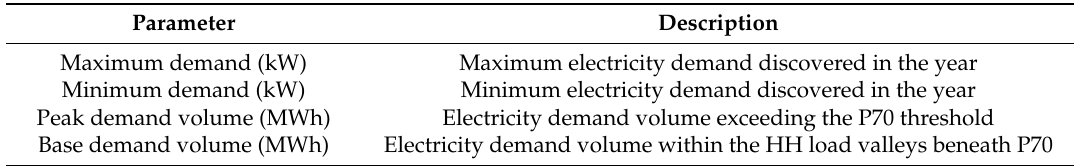
Table 1. Important result parameters (see Figure 2).